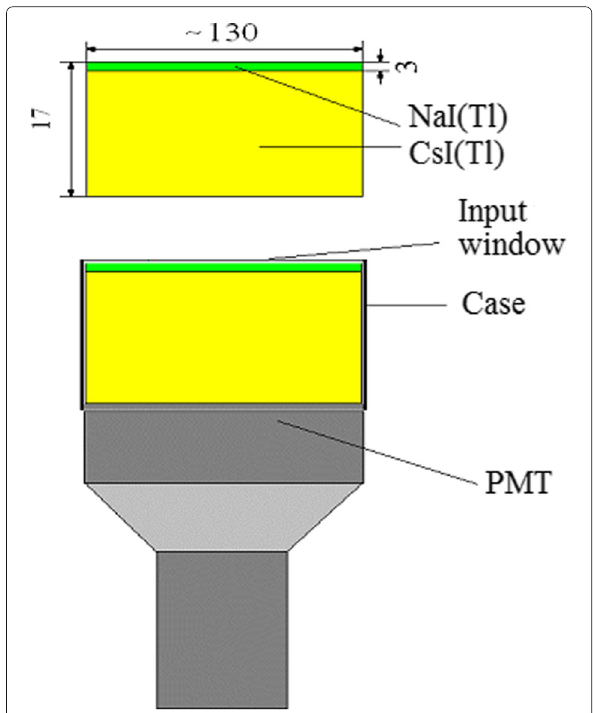
can be detected also but with the smaller efficiency of ∼ 5 to 20%. Gamma-rays having energy more than 200 keV can pass through NaI ( Tl ) layer and penetrate the CsI ( Tl ) crystal. The efficiency of CsI ( Tl ) detector at 1 MeV is about 30%. Similar calculations were made for the elec- tron beams with power energy spectra. The obtained energy threshold for electrons was derived as ∼ 300 keV for NaI ( Tl ) and ∼ 2 MeV for CsI ( Tl ) crystals, respec- tively. Both values indicate the primary energy of electrons without energy losses in the instrument cover.